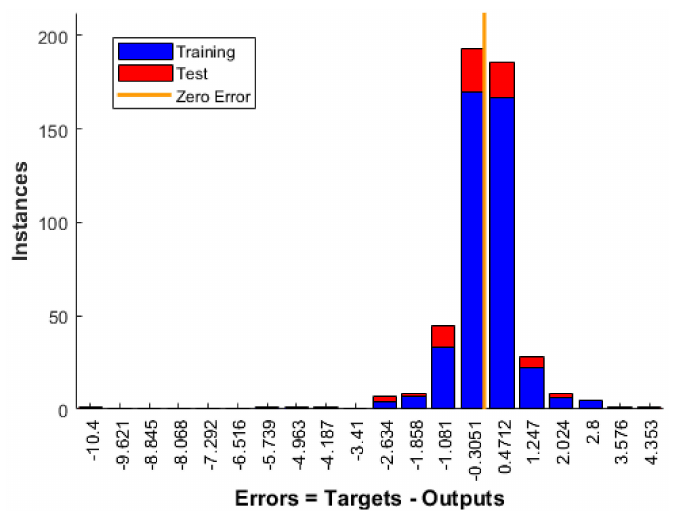
Figure 7. Error Histogram of three-layer Bayesian regularized ANN (BRANN) for GPC compressive strength prediction.